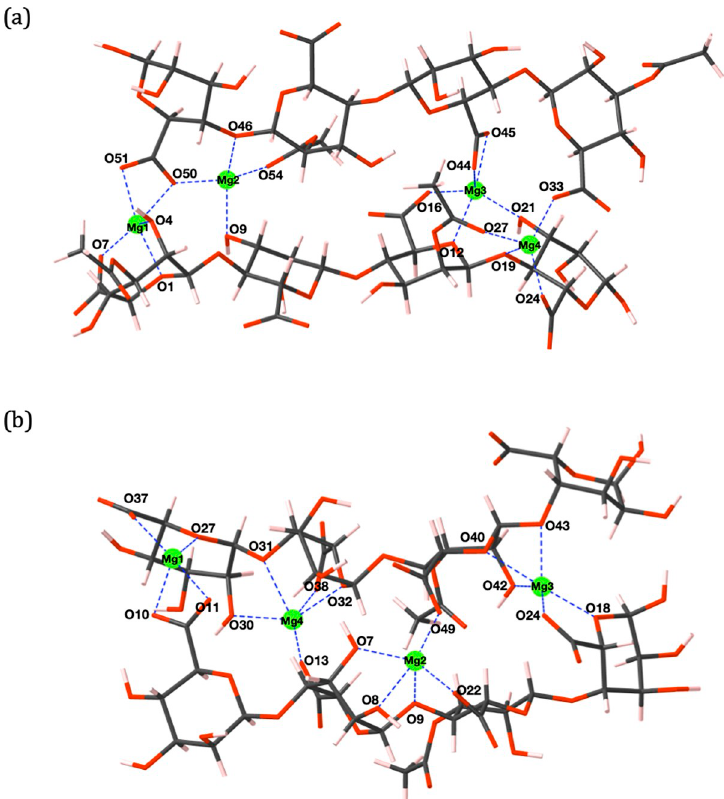
Fig 4. (a) PolyM (ap) (b) PolyMG (p) 2-chain magnesium complexes. Carbon atoms are shown in grey, oxygen in red, magnesium in green and hydrogen in pink. Oxygen atoms and cations involved in ionic bonding are labelled and the cation-oxygen bonds are shown with dashed blue